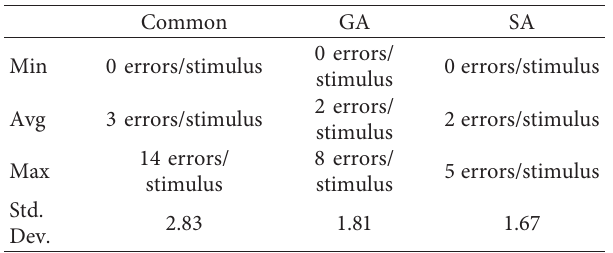
Figure 10: The effectiveness as evaluated by the participants. Table 4: Error rates.